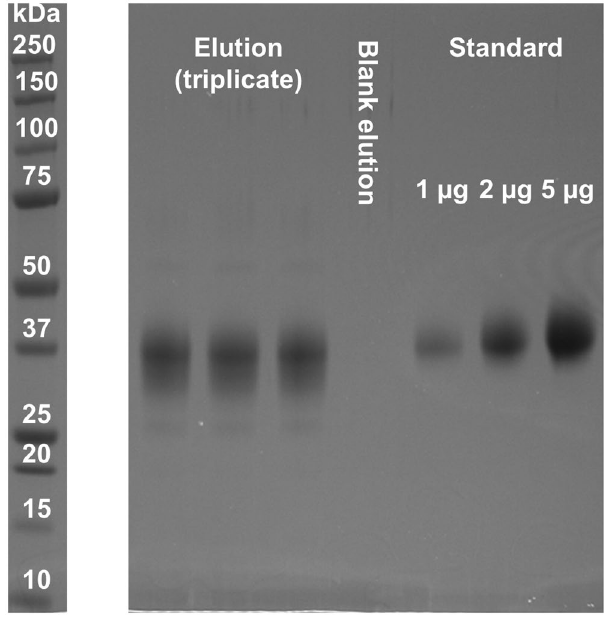
Figure 3. EPO purity after affinity purification. From left to right: Eluate of the affinity purification from CCS (triplicate); Eluate without prior application of CCS (negative control); EPO standard in ascending order of amounts (1, 2 and 5 µ g). The three different bands of each affinity purification of CCS were excised and subjected to a standard protein identification workflow (see Supporting Information Table